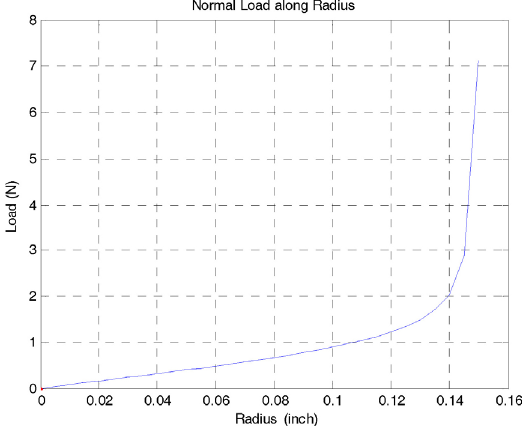
Fig. 7 Normal load along radius direction (chamfer angle = 20  ).